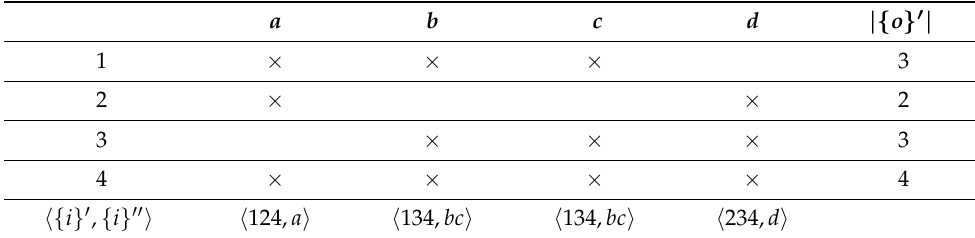
Table 3. A particular formal context with the corresponding formal context of each item.